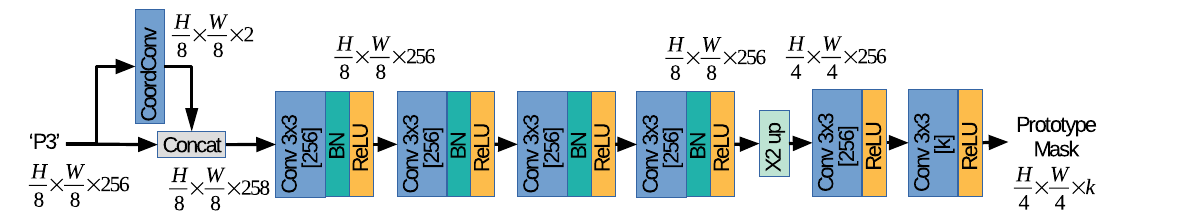
Figure 3. Proposed segmentation head branch.